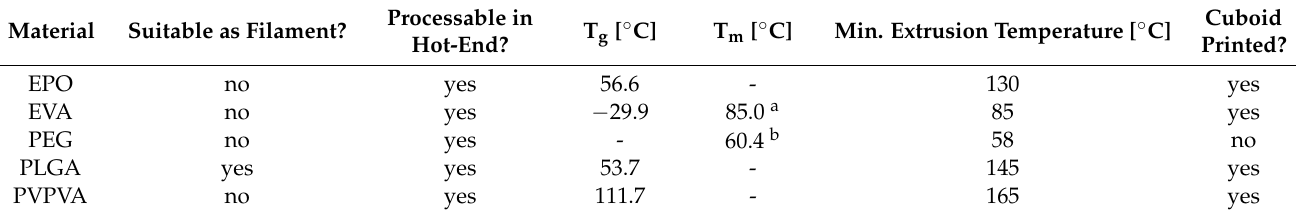
Table 3. Processed materials and their experimentally determined glass transition temperatures, melting temperatures and minimum extrusion temperatures.